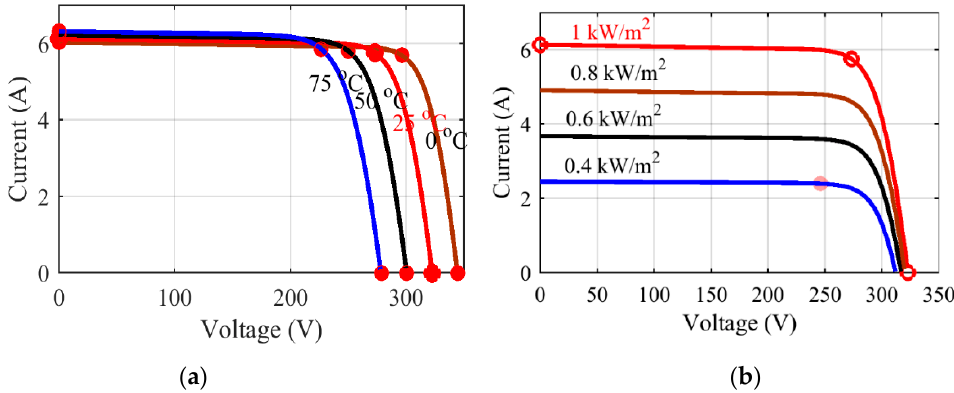
Figure 2. Current-Voltage (I-V) characteristics curve of a PV solar cell ( a ) Temperature ( b ) Irradiance